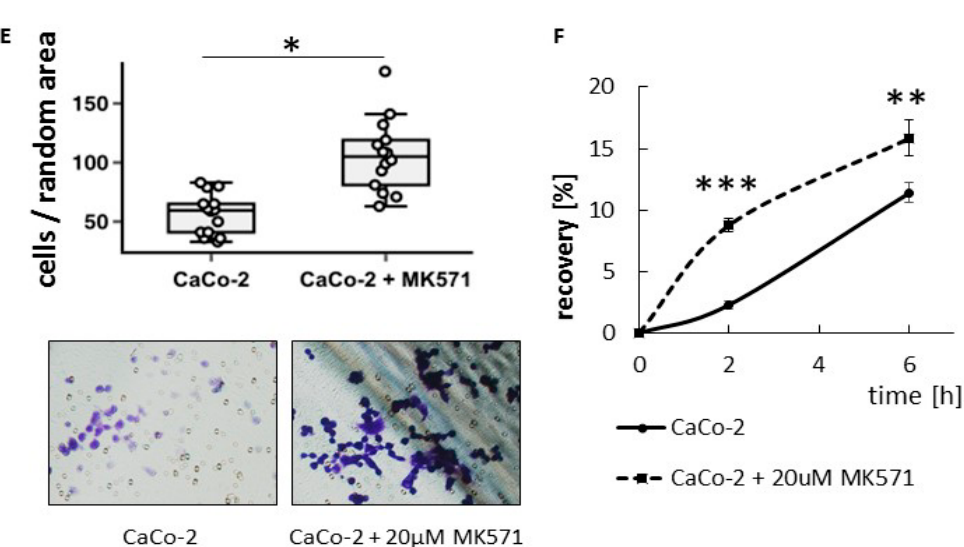
Figure 4. MK571 impact on CRC cells migratory abilities. ( A ) HT29 cells (control or overexpressing Snail) were grown to confluence on 6 well plate, next, wounded across the cell monolayer. New medium containing 20 µ M MK571 was added. Wounded area was visualized after 0, 2, 4, 6 and 24 h—and presented in using Nikon Eclipse TE 2000-U microscope (Nikon, Japan) and calculated by ImageJ software [32] . Cell motility was estimated through the quantification of the % of recovery using the equation: R (%) = [1 − (wound area at Tt/wound area at T0)] × 100,where T0 is the wounded area at 0 h and Tt is the wounded area after t; n = 3; * HT-29 / Snail (w / wo MK571) vs. HT-29 control; # HT-29 / Snail MK571 vs. HT-29 / Snail * p < 0.05; ** p < 0.005; *** p < 0.001, NS—no statistically significant. ( B ) Representative picture of wound healing assay. ( C ) Gelatinolysis mediated by HT-29 measured by in-situ zymography. The pericellular proteolytic abilities of HT-29 were analyzed by a measure of the increase in FITC fluorescent intensity from digested DQ gelatine relativized to control cells presented as 100%; n = 3 ( D ) HT29 cells, transwell assay. Cells incubated for 24 h with MK571 20 µ M, or untreated once were seeded on Matrigel coated transwell inserts in the upper chamber in medium supplemented with 0.1% bovine albumin serum (BSA) (w / wo 20 µ M MK571). Full medium in lower chamber served as chemoattractant for cell invasion. Membrane were cut out and all cells from membrane were calculated after 6 h of incubation followed by hematoxylin / eosin staining. Number of control HT-29 cells that transmigrate into transwell membrane through 8 µ M pores covered with Matrigel was set as 100%, next number of other cells was calculated and presented as % of control. ( E ) CaCo-2 cells, transwell assay. Cells were incubated for 24 h with MK571 20 µ M, or untreated once were seeded on un-coated transwell inserts (8 µ M pores) in the upper chamber in 2% BSA medium (w / wo 20 µ M MK571). Full medium in lower chamber served as chemoattractant for cell migration. Cells were calculated in randomly assigned areas after 3 h of incubation followed by hematoxylin / eosin staining. Interquartile range (Q1–Q3) is shown as gray box with median (Q2) with all data points from all ( n = 3) experiments overlap on the box plot. ( F ) CaCo-2 cells, wound healing assay. Cells were seeded on collagen coated 6-well plates to full confluence. Next wound was done across cell monolayer, rinsed with phosphate bu ff er (PBS) PBS. Next fresh medium w / wo 20 µ M MK571 was added. Cells were visualized every 2 h and % of wound enclosure was calculated as in A). * p < 0.05; ** p < 0.005; *** p < 0.001, NS—not statistically